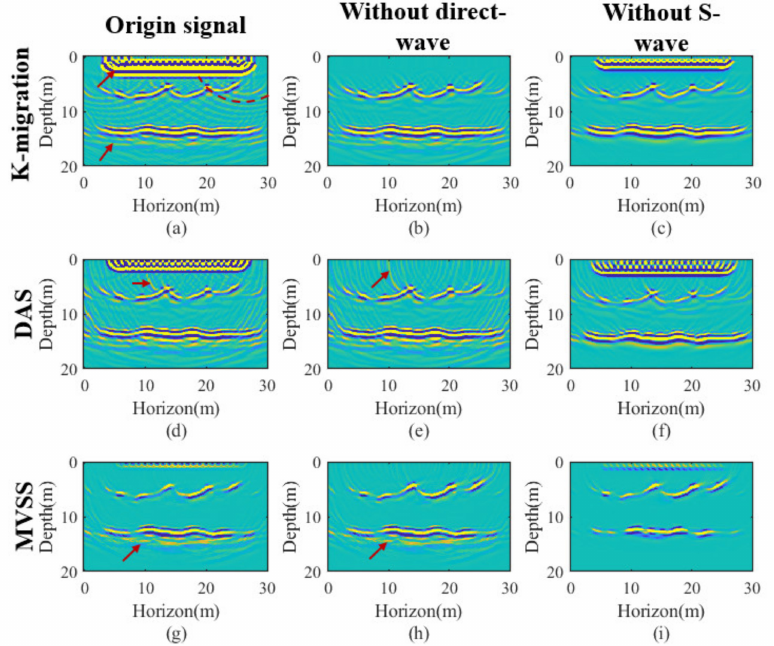
Figure 21. Imaging results after eliminating either surface waves or S-waves. ( a ) Kirchhoff migration result using the original signals. ( b ) Kirchhoff migration result using signals without surface waves. ( c ) Kirchhoff migration result using signals with only P-waves. ( d ) DAS beamforming result using the original signals. ( e ) DAS beamforming result using signals without surface waves. ( f ) DAS beamforming result using signals with only P-waves. ( g ) MVSS beamforming result using the original signals. ( h ) MVSS beamforming result using signals without surface waves. ( i ) MVSS beamforming result using signals with only